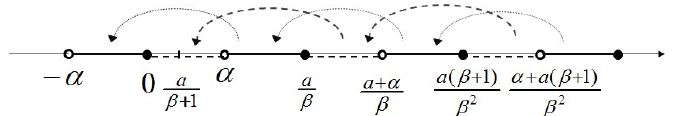
Figure 3. Illustration of Theorem 6 Statement 2: if x 0 belongs to dotted intervals, then ∈ [0; α [; if x 0 belongs to bold intervals, then ∃ n 2 x n ∃ n 1 x n 1